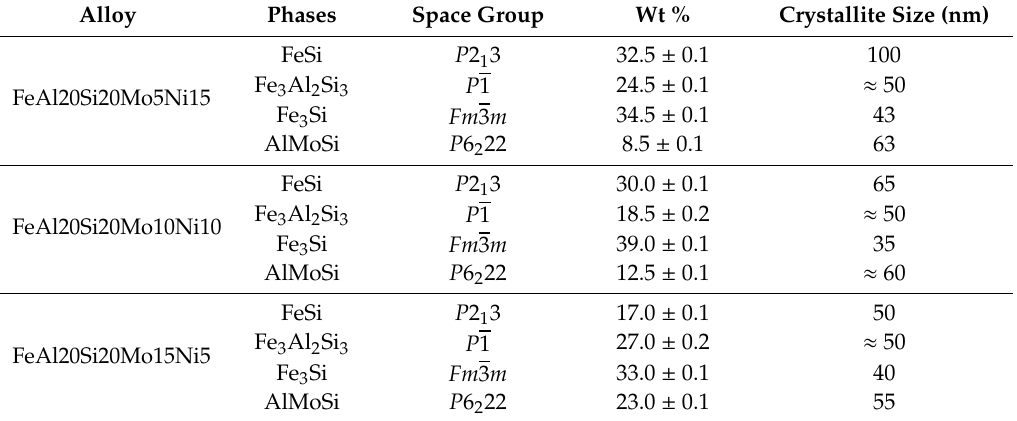
Table 2. The phase parameters, phase fractions, and crystallite sizes determined by Rietveld analysis.